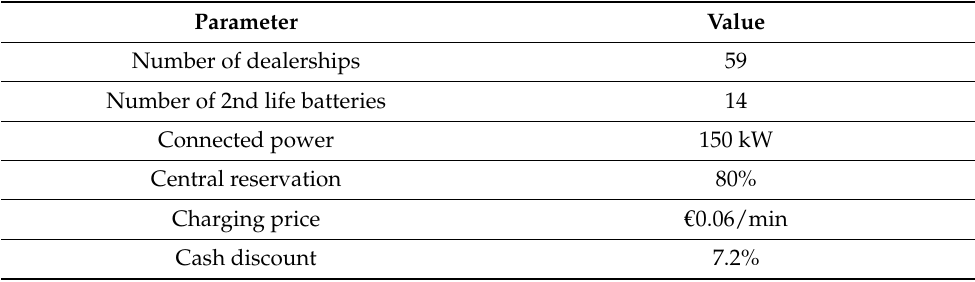
Table 14. Input investments.